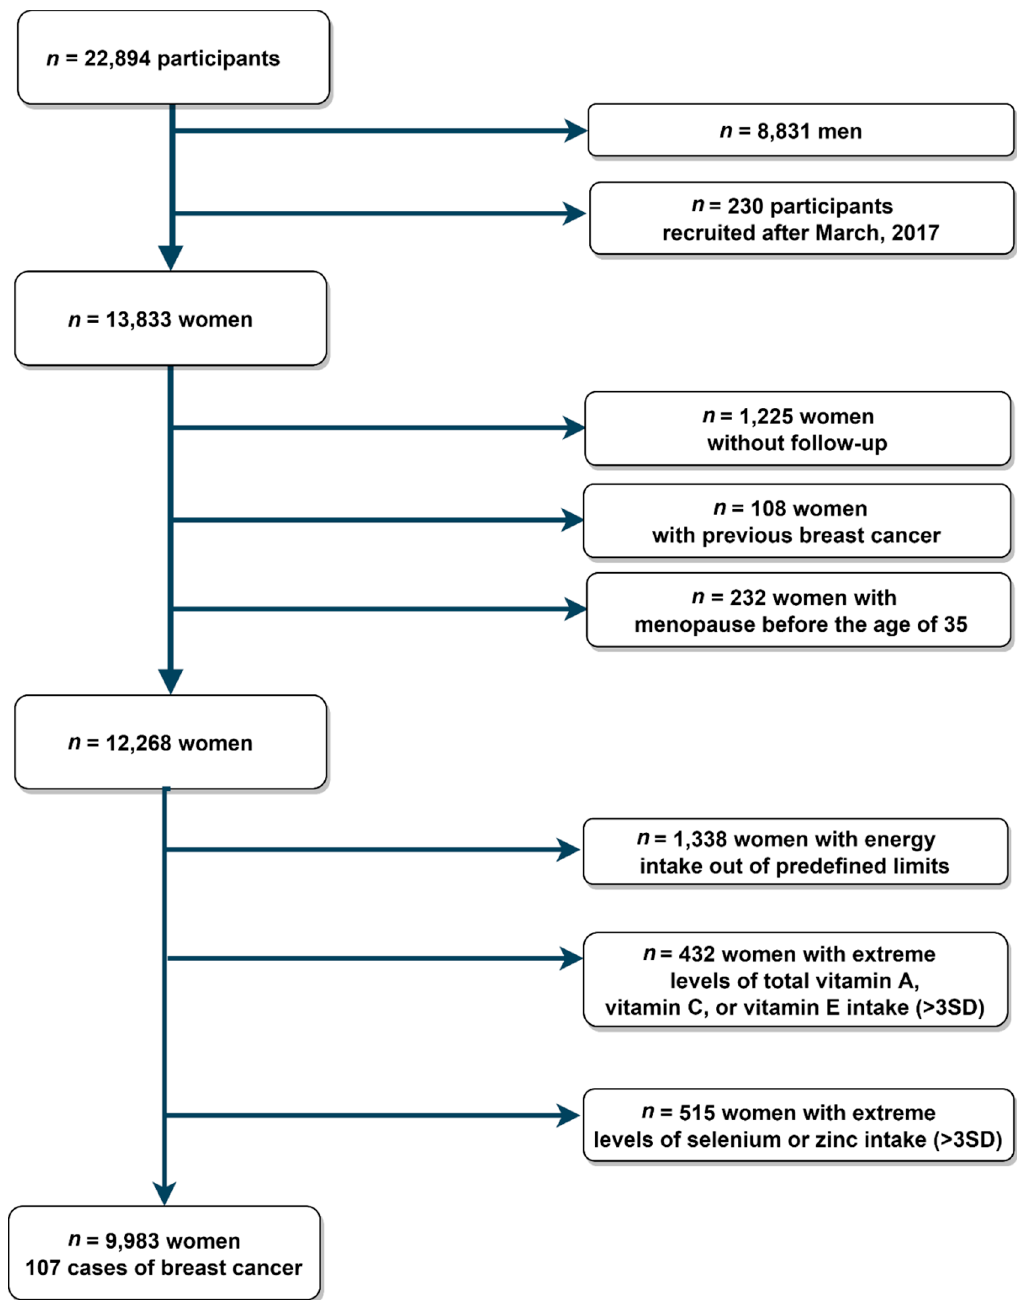
Figure 1. Flowchart of study participants for the assessment of the association of vitamin A, vitamin C, vitamin E, selenium, and zinc and incident intake and breast cancer in the SUN (University of Navarra Follow-up) Project (1999–2020).